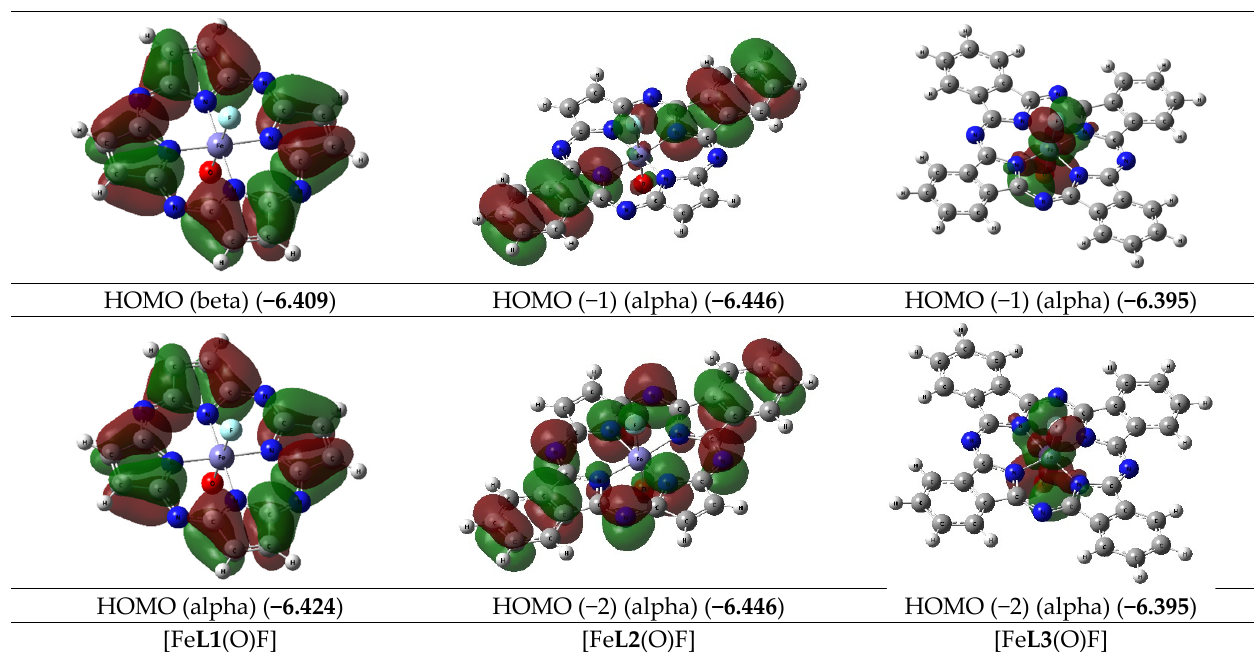
Figure 2. The images of HOMO and LUMO in the Fe L1 (O)F] (ground state–spin doublet, M S = 2), Fe L2 (O)F] and [Fe L3 (O)F] (ground state–spin quartet, M S = 4) according to the DFT B3PW91/TZVP method. The energies values of the indicated MOs (in brackets) are given in eV. The symbol “alpha” belongs to electron with spin (+1/2), symbol “beta”, to electron with spin ( − l/2). The abbreviations “HOMO ( − 1) (alpha)” and “HOMO ( − 2) (alpha)” are used to designate MOs located slightly below HOMO (alpha) and closest to it in order of decreasing energy values.